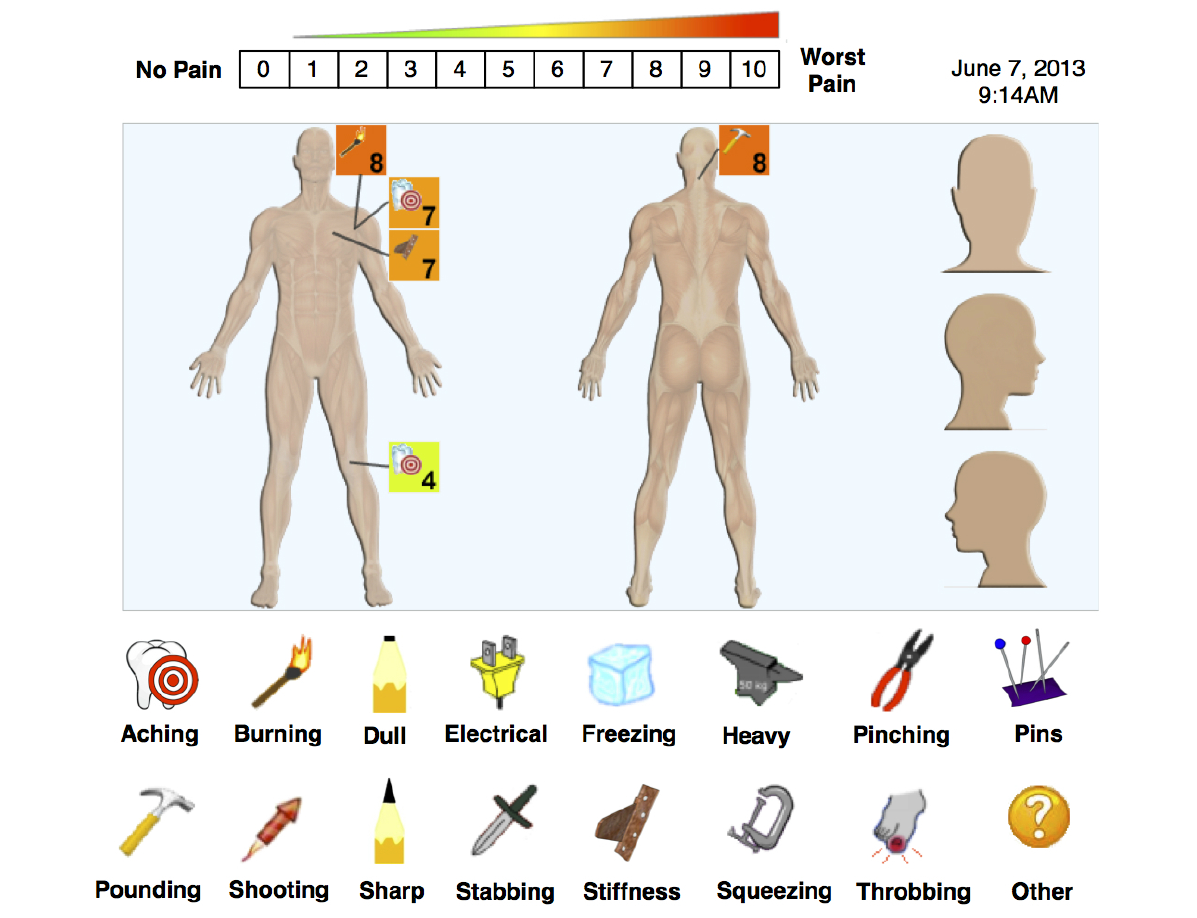
Figure 1. Screenshot of Pain-QuILT user interface for self-reporting the quality, intensity, and location of current pain. Copyright McMaster